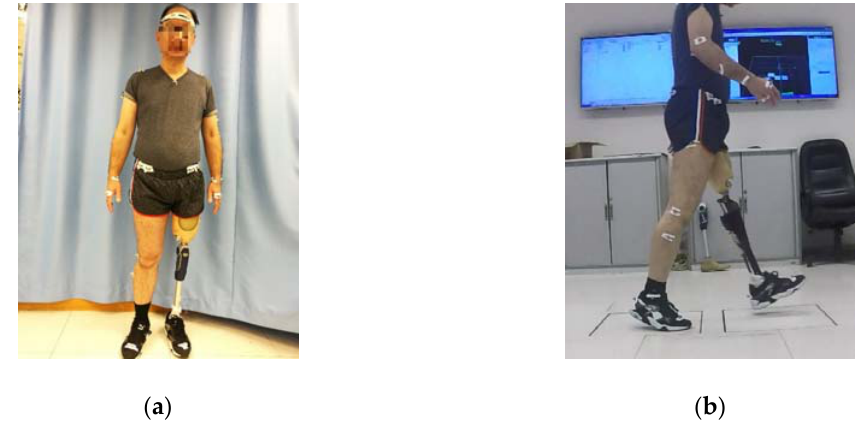
Figure 1. Illustration of the gait experiment: ( a ) one of the transfemoral amputee participants, ( b ) the amputee affixed with markers walking under the motion capture system (MOCAP) and on the force platform.